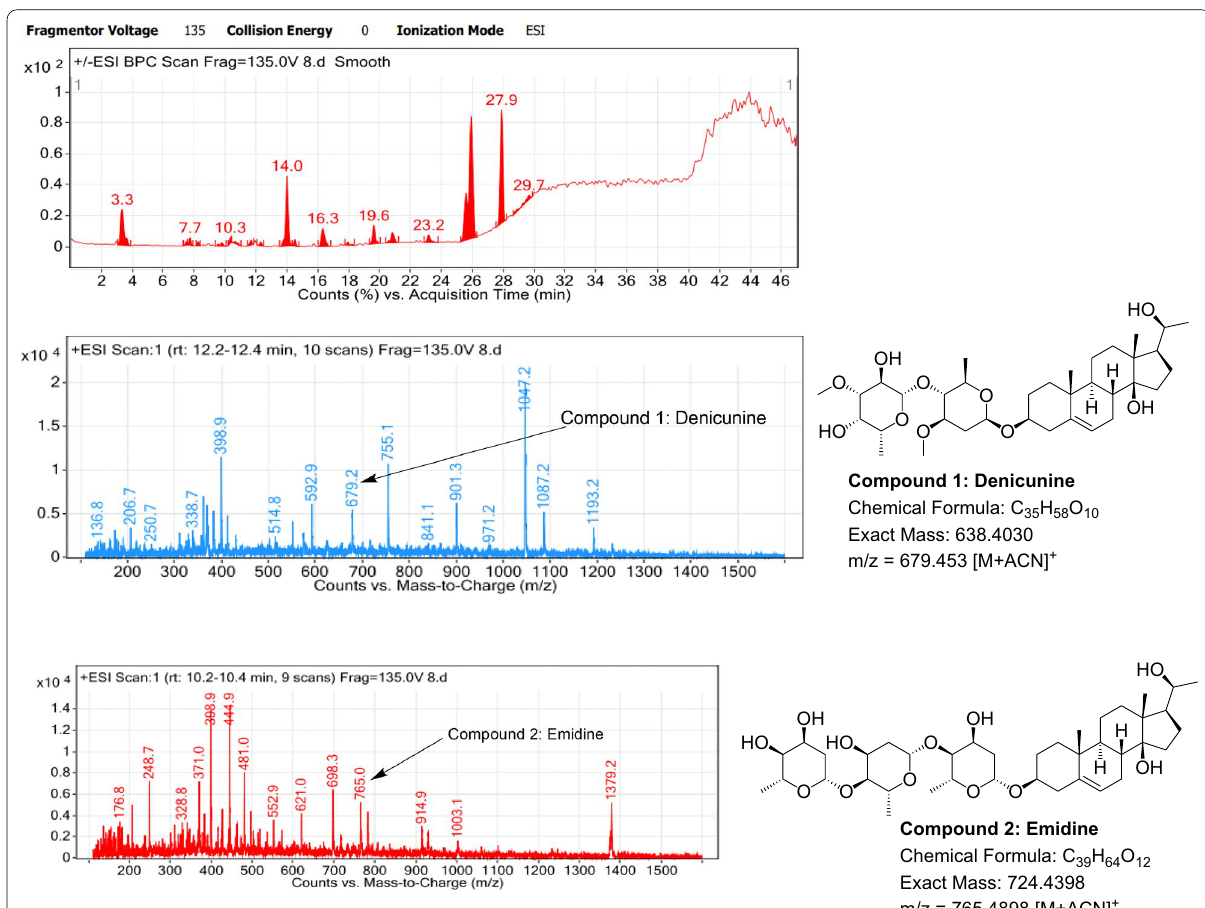
Fig. 14 LC–MS chromatogram of root extract of Hemidesmus indicus showing marker